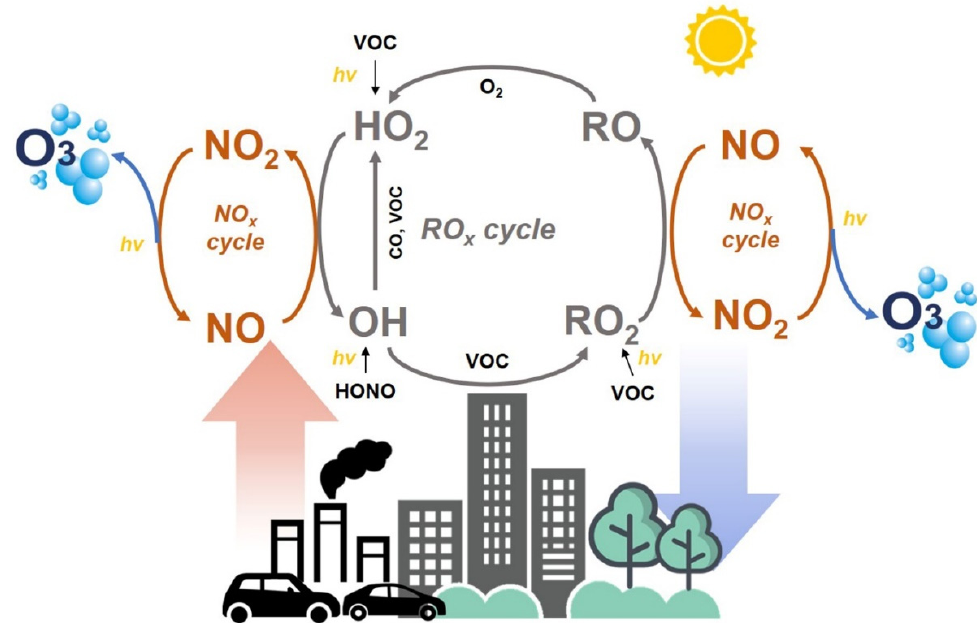
Figure 1. Diagram of the main chemical reactions involved in O 3 formation. Adapted from Fitzky et al. [10].